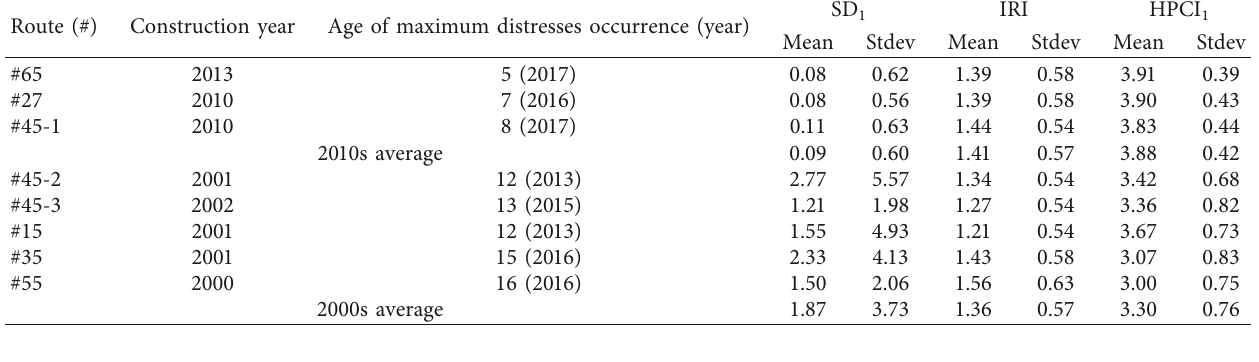
Table 6: HPMS data at the time of maximum distresses occurrence.